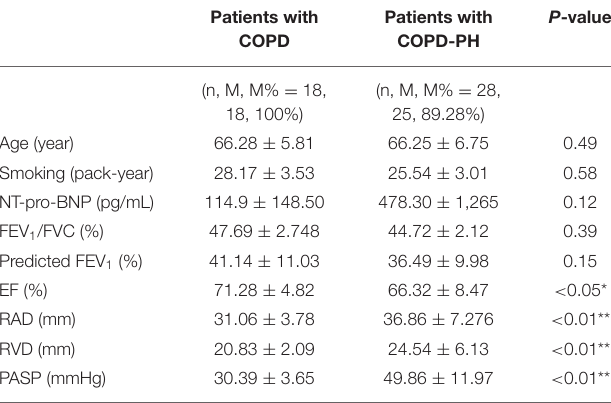
TABLE 2 | Clinical characteristics of patients for ELISA validation. Patients with COPD